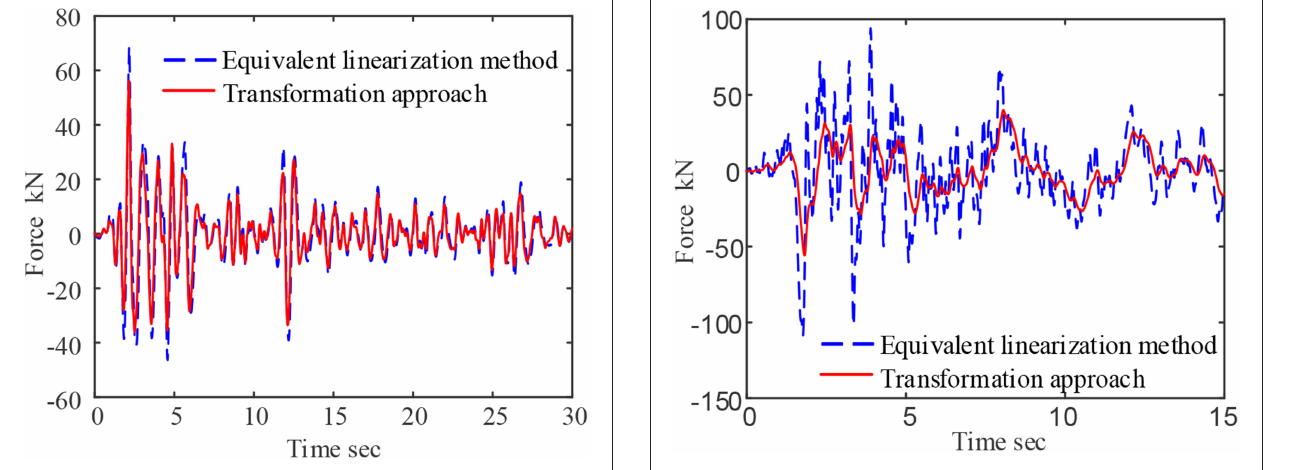
FIGURE 7 | Force-time curve of viscoelastic damper under seismic load (assuming working frequency is